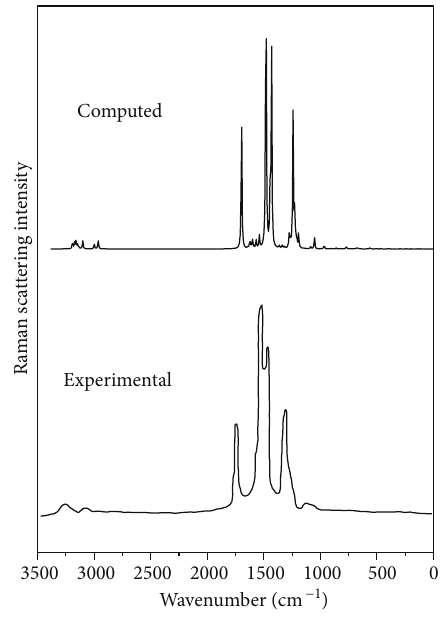
Figure 3: The experimental FT-Raman spectrum of DMAB and the computed (scaled) Raman spectrum of DMAB by DFT/B3LYP/6-